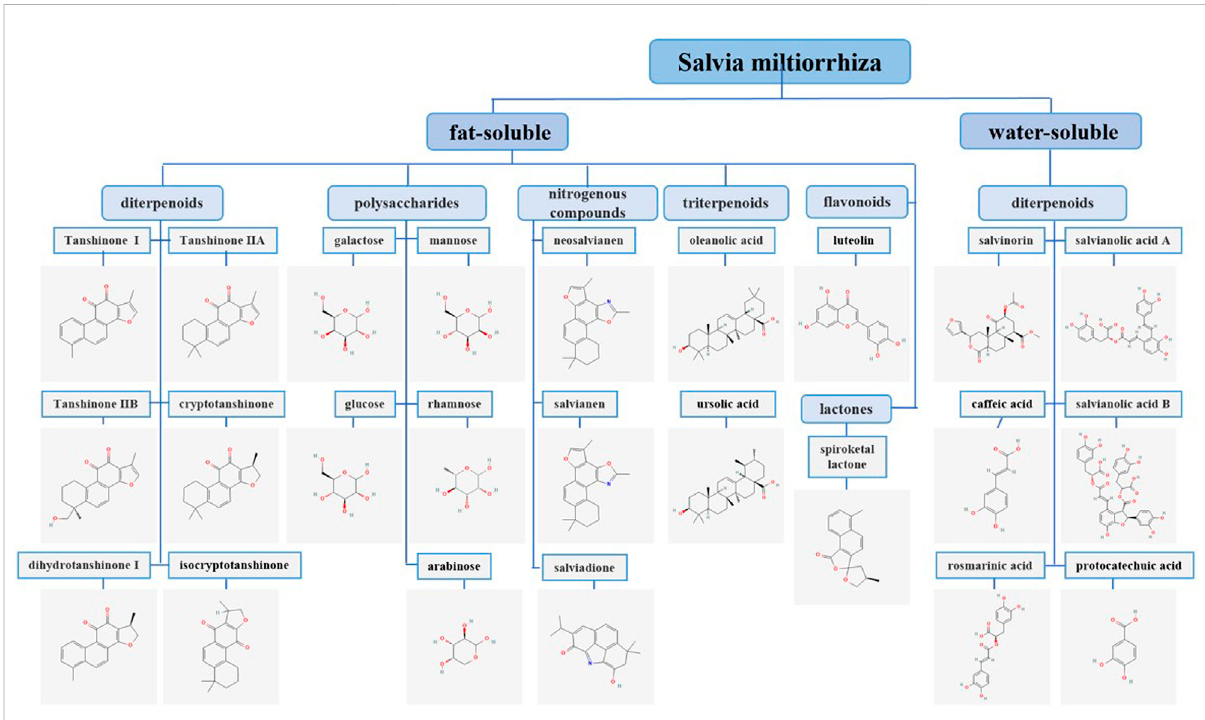
FIGURE 1 Classi fi cation and chemical structures of S. miltiorrhiza bioactive compounds. The chemical structures of the S. miltiorrhiza constituents included in this publication were obtained from PubChem and drawn with the ChemDraw